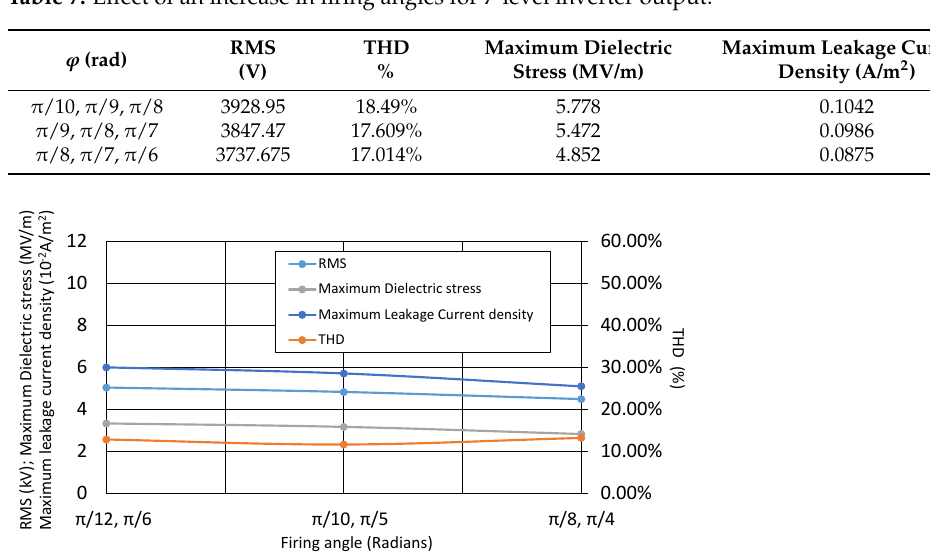
Figure 12. Effect of increasing firing angle in a 5-level inverter. Left Vertical axis: RMS in kV; Maximum Dielectric stress in MV/m; Maximum leakage current density in 10 − 2 A/m 2 ; Right Vertical axis: THD in %.